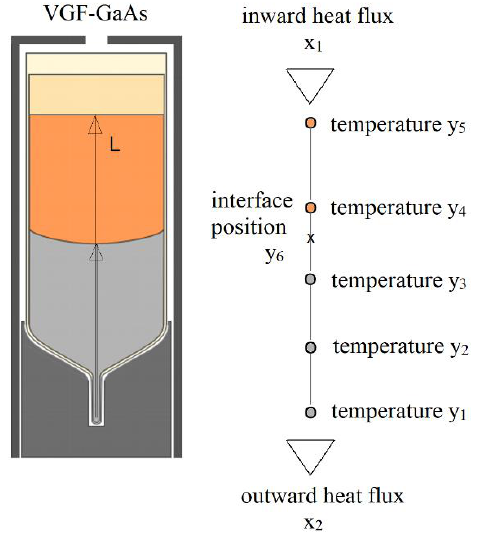
Figure 1. Sketch of the VGF-GaAs hot zone with related neural network inputs (incoming x 1 and outgoing x 2 heat fluxes) and outputs (temperatures in GaAs at 0–25–50–75–100% of its length y 1 to y 5 and interface position y 6 ) related to 1D model of melt and crystal.